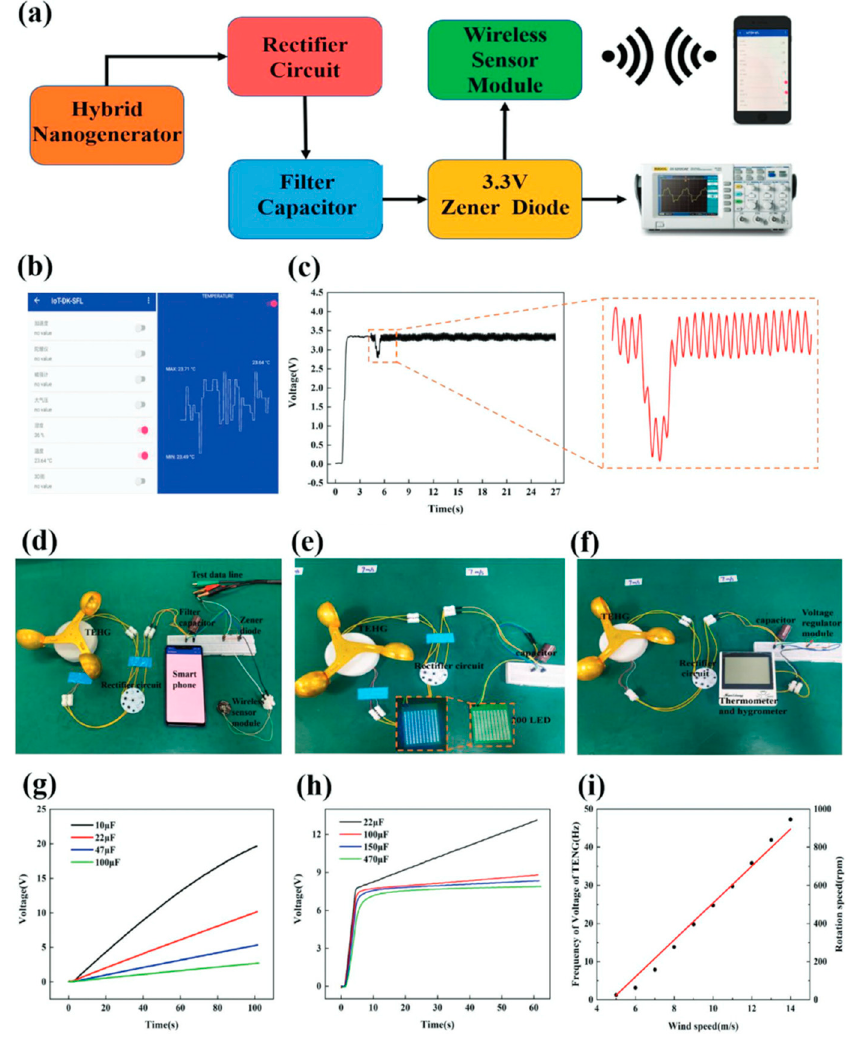
Figure 9. The application of the TEHG was proposed by Zhao et al. [156]. ( a ) Schematic view of the designed circuit for continuously supplying energy for the wireless sensor network node. ( b ) Mobile phone display to receive sensor data. ( c ) Mobile phone display to receive voltage data. ( d ) The test circuit of the TEHG to power the wireless sensor network node. ( e ) TEHG used to light up 200 LEDs. ( f ) TEHG supplies power to the thermometer and hygrometer device. ( g ) TENG is used to charge different capacitors. ( h ) TEHG is employed to charge several capacitors. ( i ) Relationship between the output voltage frequency, wind speed, and rotation speed. Reprinted with permission from [156]. Copyright 2021, John Wiley and Sons.